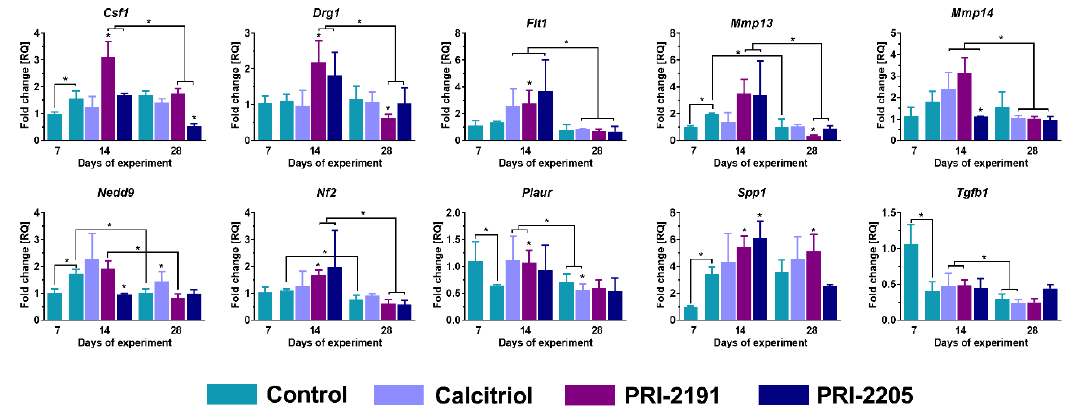
Figure 4. Changes related to gene expression in tumor tissue of 4T1 tumor-bearing aged OVX mice. Expression of selected genes in tumor tissue of aged OVX mice estimated by real-time PCR. The analysis was performed on tissue samples harvested at days 7, 14, and 28. 25 ng of cDNA was used for a single reaction and each sample was applied in triplicate (day 0). Phosphoglycerate Kinase 1 ( Pgk1 ) was used in the analysis as a housekeeping gene. Briefly, 60-week-old mice were subjected to ovariectomy or sham surgery. After 4 weeks, 4T1 cells were inoculated (day 0) orthotopically and the subcutaneous administration of tested compounds (three times a week) was initiated on day 7 at the following doses: calcitriol, 0.5 µg/kg; PRI-2191, 1.0 µg/kg; and PRI-2205, 10.0 µg/kg. The number of mice analyzed was 3–7 per group. Data presentation: mean with standard deviation (SD). Statistical